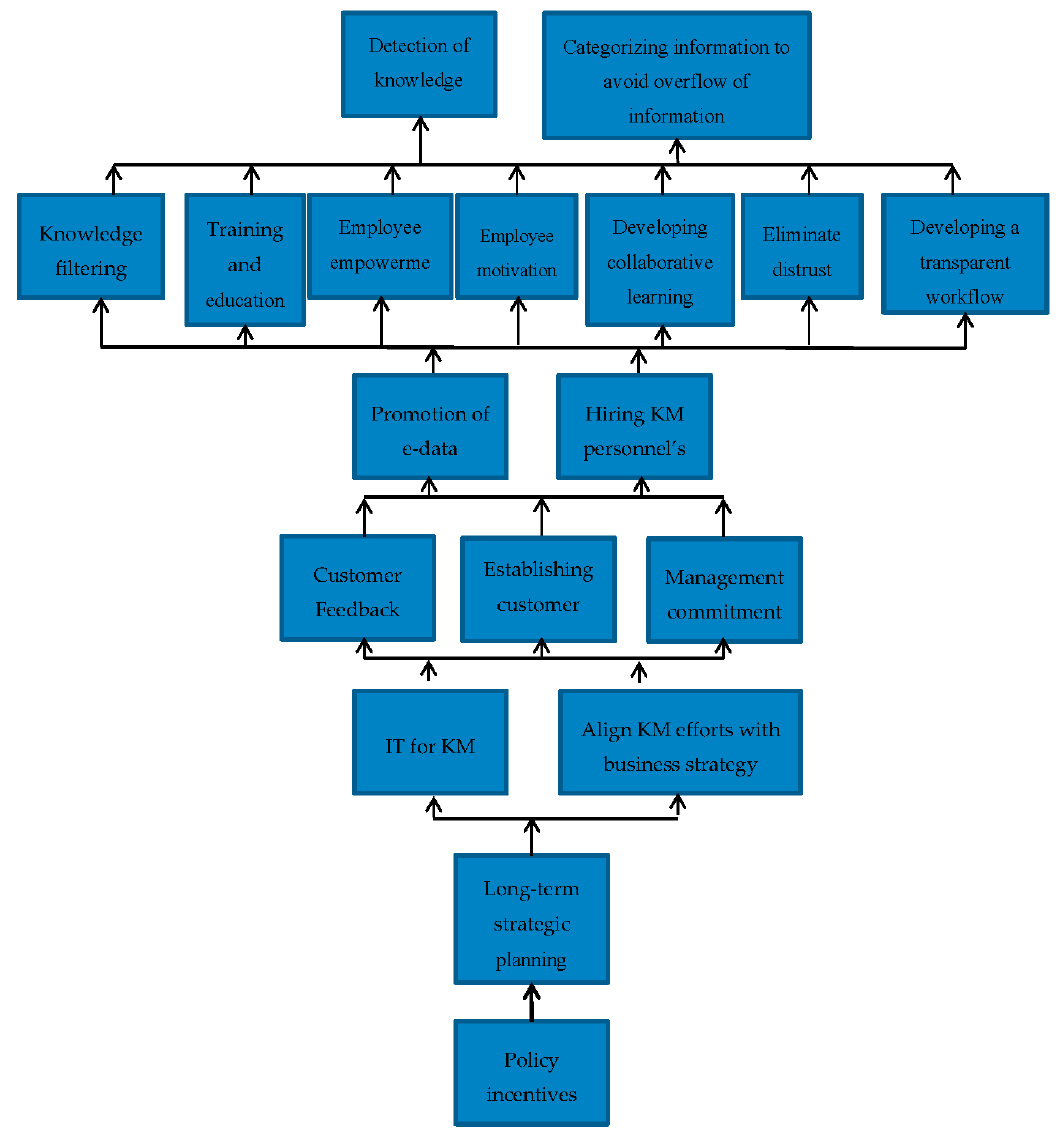
Figure 2. Interpretive Structural Modeling model for enablers of knowledge management implementation in the healthcare sector of Pakistan.